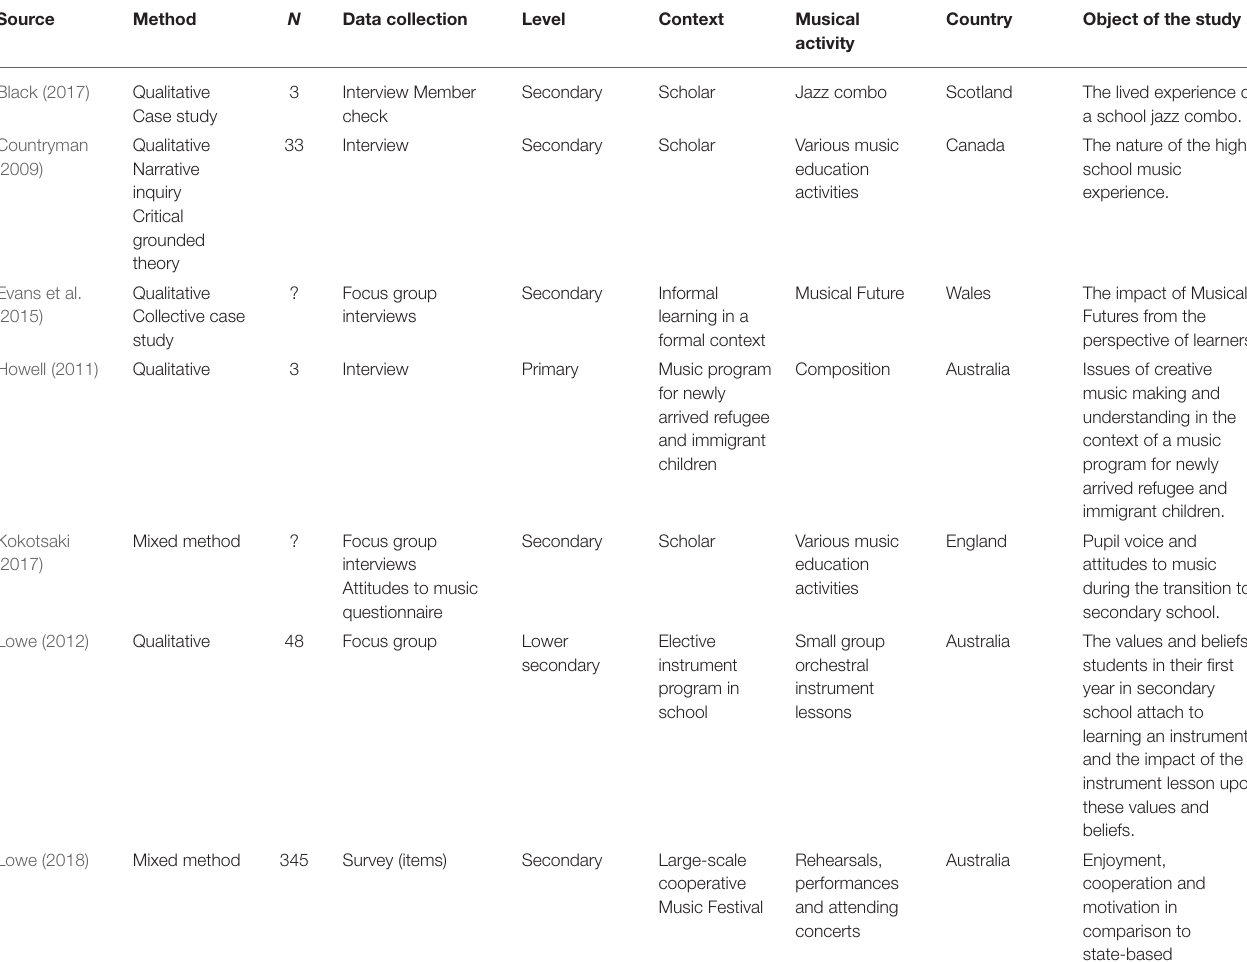
TABLE 3 | Summary of the literature